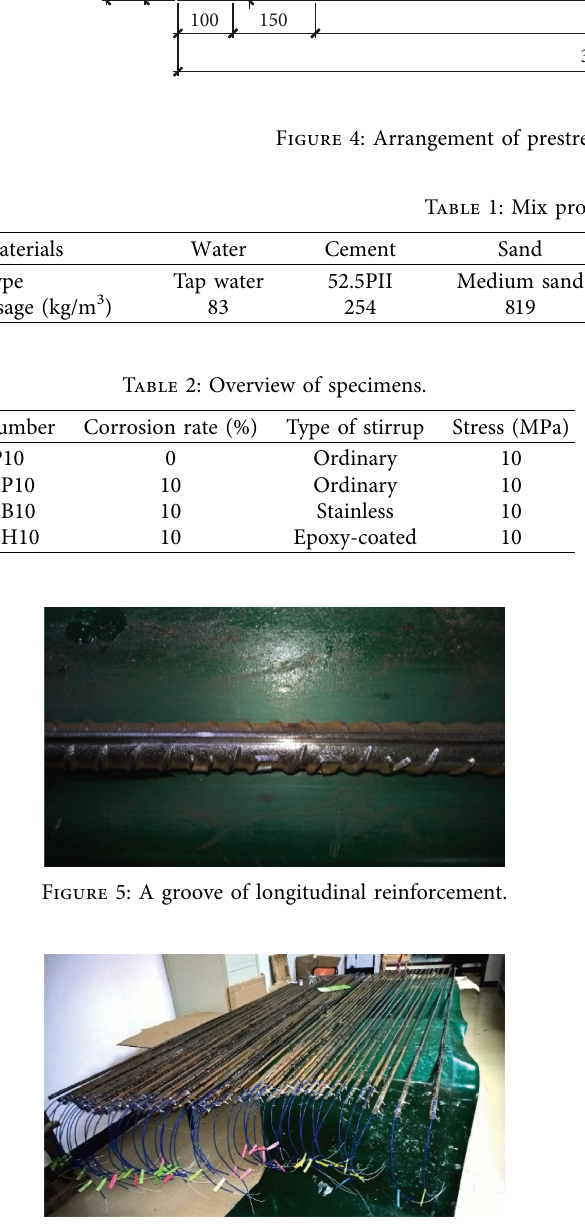
Figure 6: Arrangement of FBG.